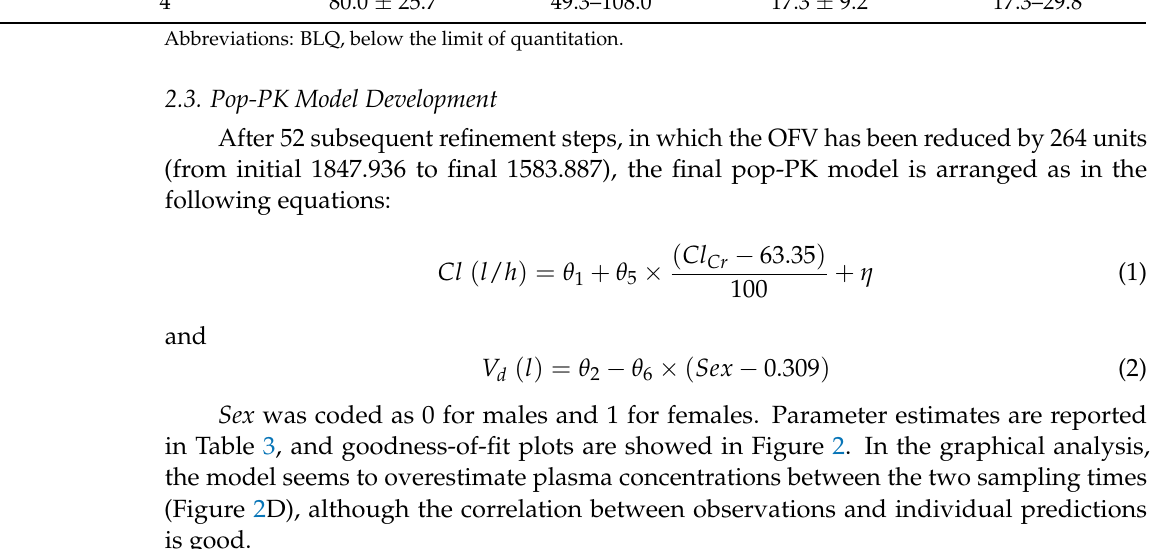
Table 3. Final parameter estimates of the pop-PK model (left) and mean bootstrap estimates (right).